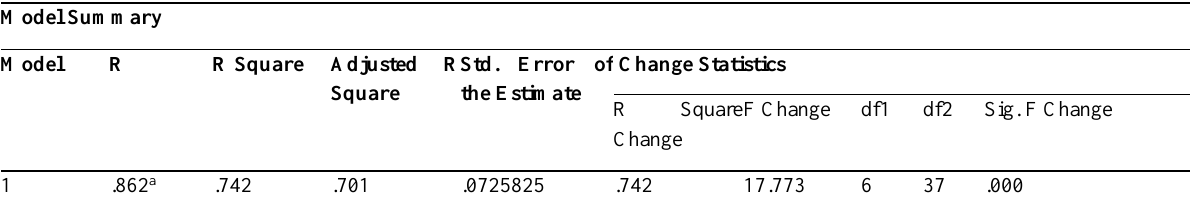
Table 9: Model Summary Extent of Utilization of Performance Contracting as a Tool for Strategy Implementation